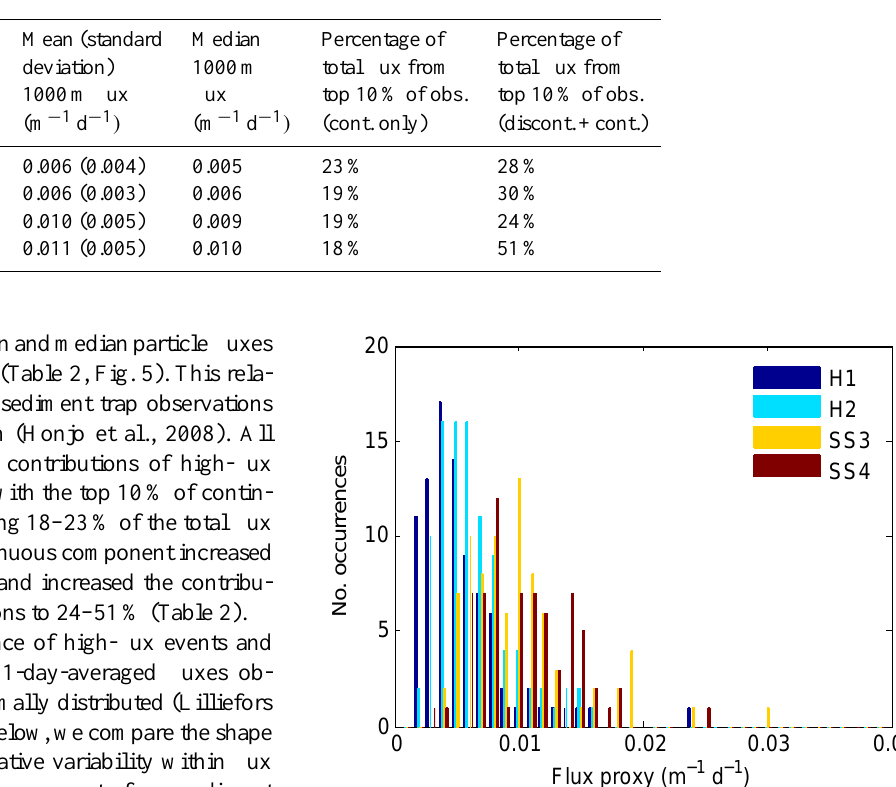
Table 2. 1-day-binned flux proxy time series statistics for floats H1, H2, SS3, and SS4.